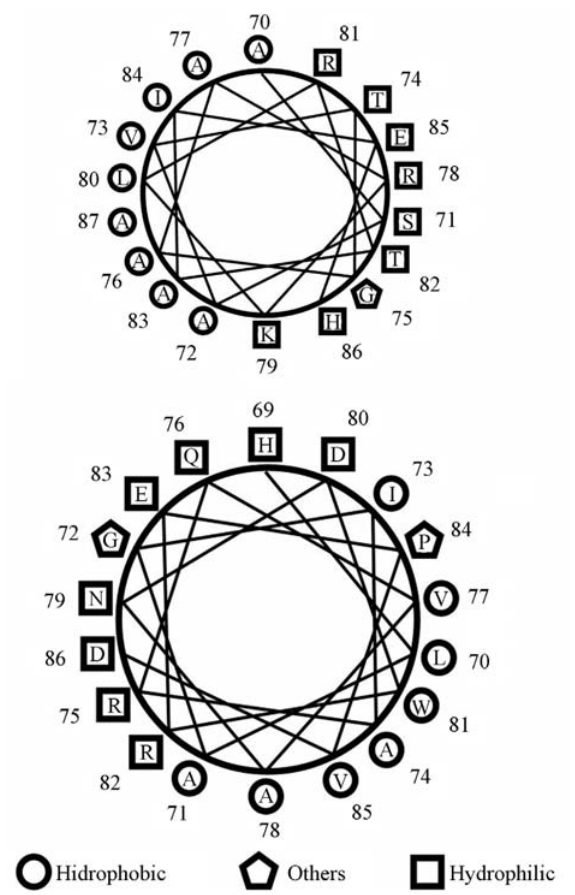
Figure 2 - Predicted amphiphatic α -helical wheel of potential secretion chaperone.ThegenesNP_640774(a)andNP_640641(b)wereselectedas potential secretion chaperones because they were located near pathogenic and virulence clusters and because they had predicted protein physico-chemical characteristics similar to those of type III chaperones (see Table 2). Analysis with the ANTHEPROT software package (ANa- lyse THE PROTeins; Deleage et al. , 1988; Deleage et al. , 2001) allowed the prediction of a potential amphipathic α -helical wheel at the protein C-terminus. Amphipatic α -helices have predominantly nonpolar amino acid residues along one side and polar residues along the other